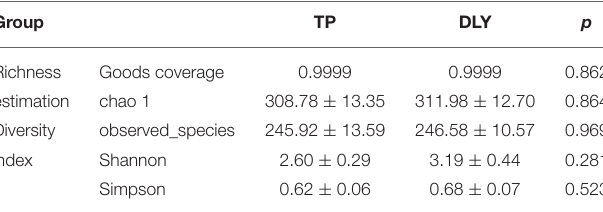
TABLE 5 | Comparison of alpha diversity estimation of the 16S rRNA gene libraries for TP and DLY pigs at 97% similarity.